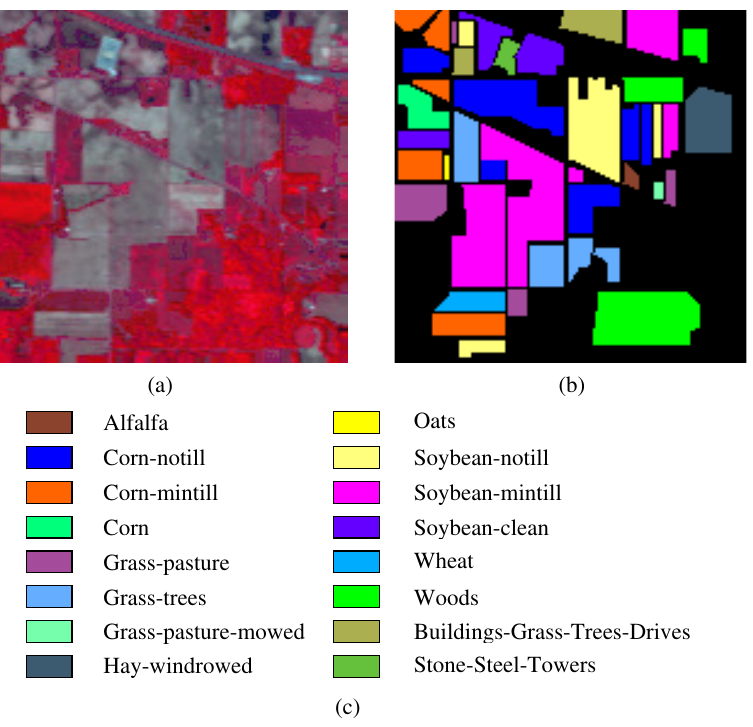
Figure 3. Indian Pines dataset. ( a ) Three-band color composite of the Indian Pines image. ( b , c ) Ground truth image and reference